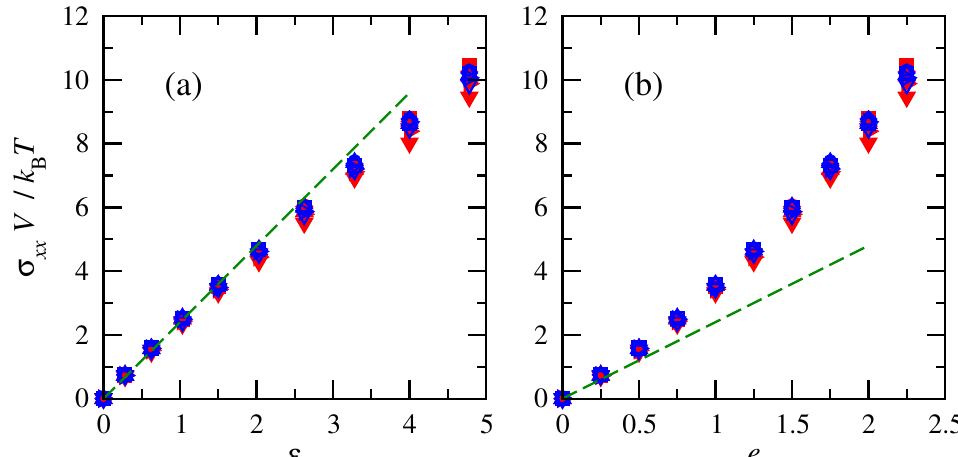
Figure 5. Normalized tensile stresses vs. ( a ) finite strain and ( b ) engineering strain for cis- and trans- 1,4-polybutadiene RIS chains of all sizes at 343 K. Symbols follow convention of Figure 4. Dashed lines indicate an initial linear fit with E = 2.4 k B T / V .